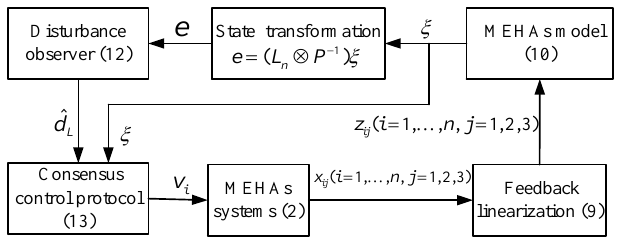
Figure 2. The flow chart of the average consensus control